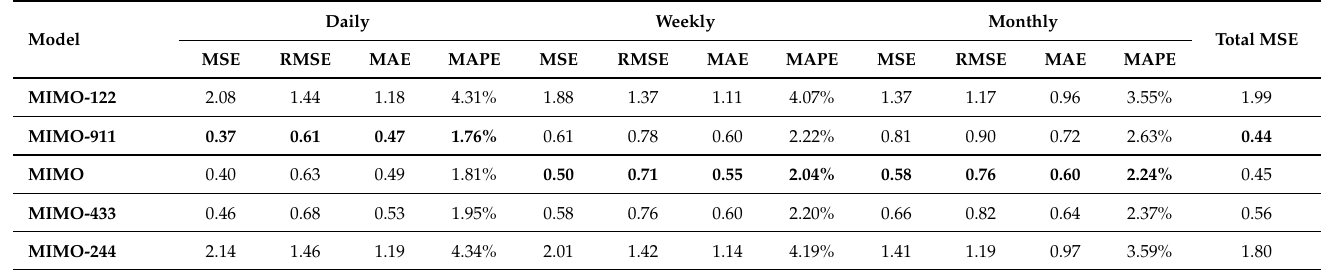
Table 1. The results of MIMO with different settings for the weights of loss